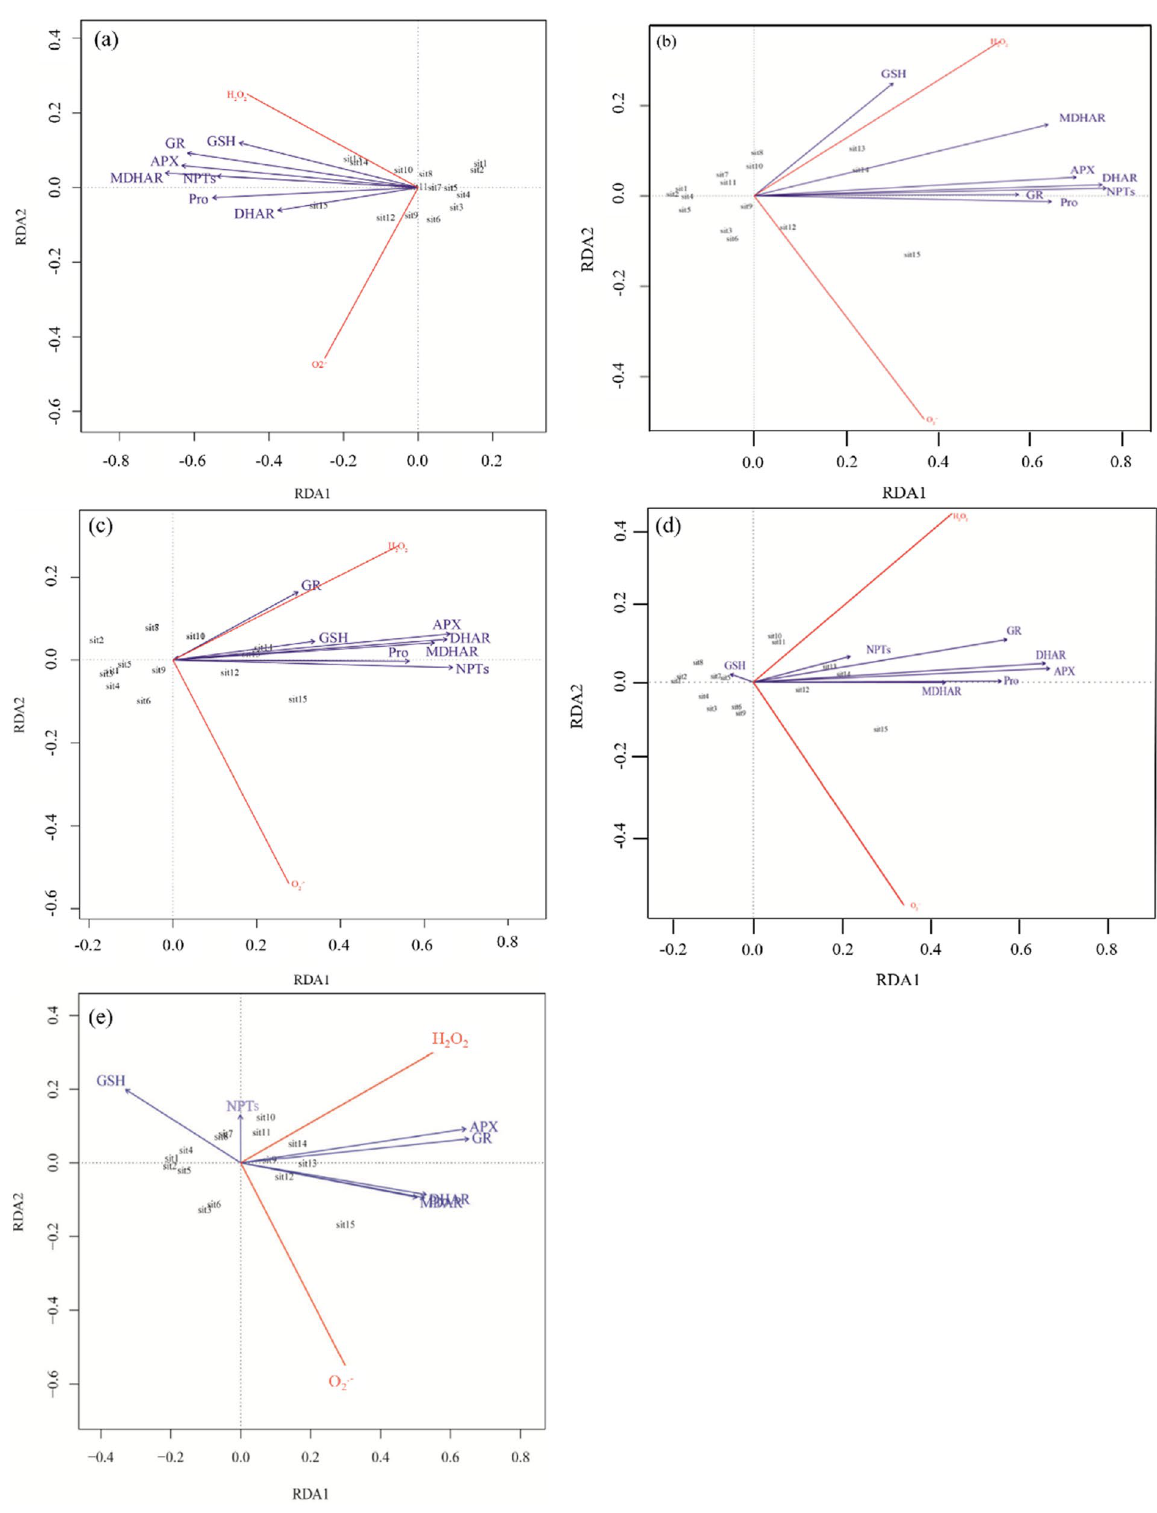
Figure 6. Triplot of the redundancy analysis (RDA) of H 2 O 2 and O 2·− generation rate in leaves of Lonicera japonica Thunb. cuttings exposed to different Cd treatments. ( a ) 10 mg kg −1 Cd; ( b ) 30 mg kg −1 Cd; ( c